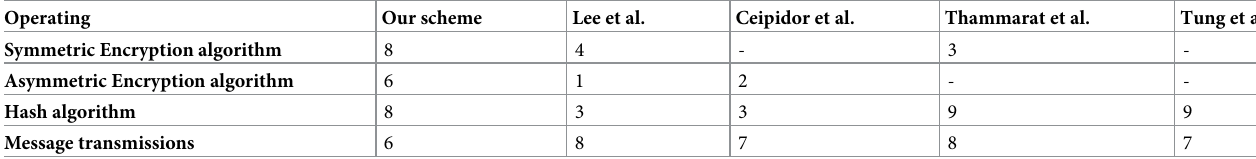
Table 2. Comparison of confidentiality and performance analysis.